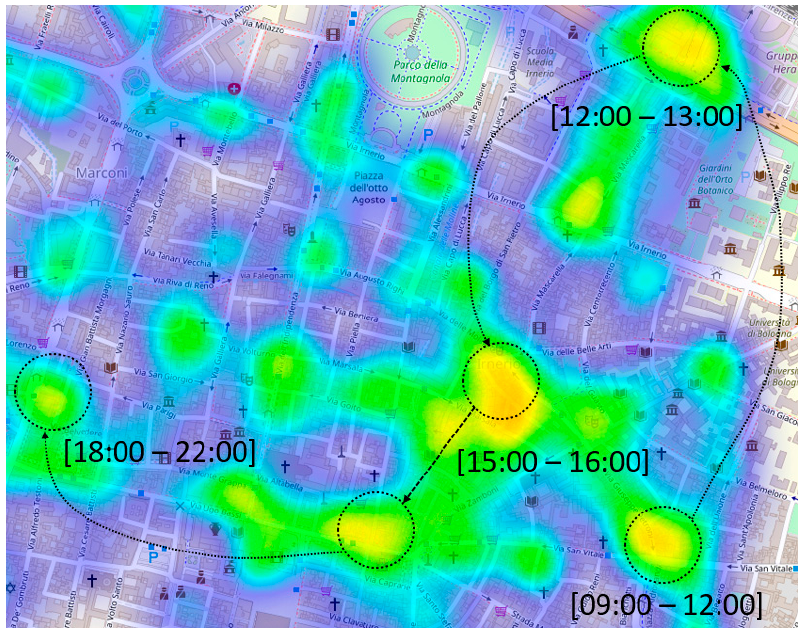
Figure 4. Graphical representation of stop-places for ParticipAct data set. The heatmap shows the stop-places and the time of day such places become active.